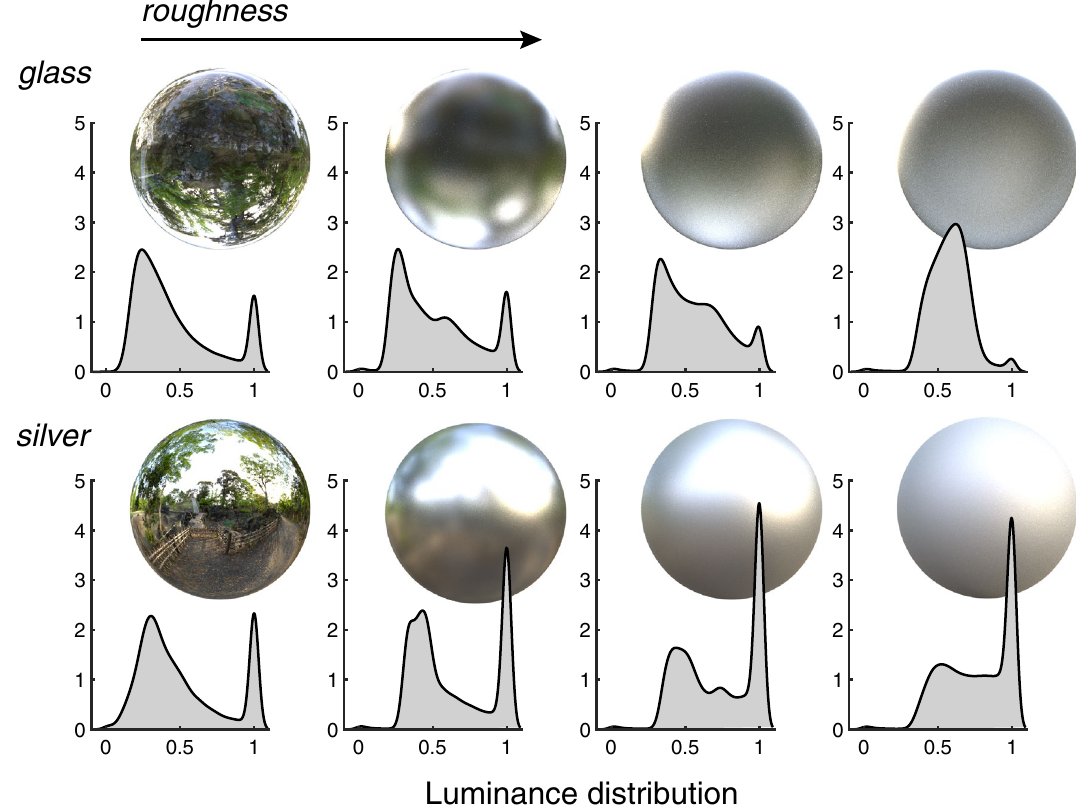
Figure 6. Comparing the effect of roughness on glass and silver objects. Glass (top row) and silver (bottom row) spheres have been rendered with varying physical roughness, increasing to the right. The objects have a similar luminance profile when completely smooth, making it hard to discern which material is which. However, increasing roughness has a more pronounced effect on the glass object than the silver object, as the luminance distribution is more tightly constrained, despite a similar apparent level of image